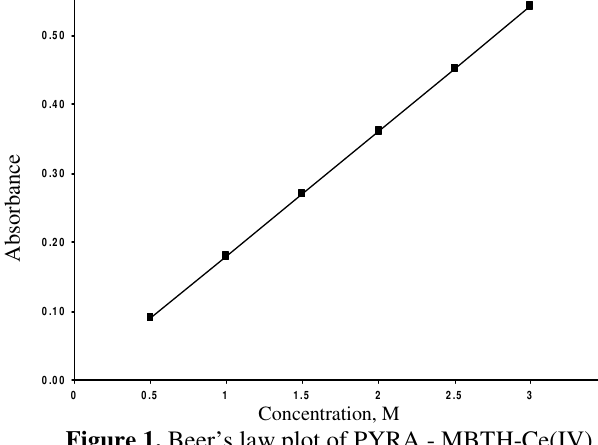
Figure 1. Beer’s law plot of PYRA -